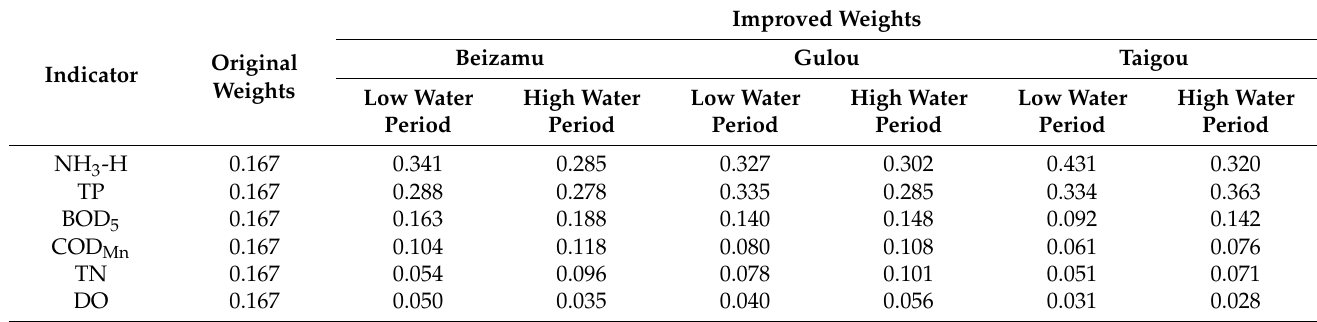
Table 6. The original weights and improved weights of the three river sections.